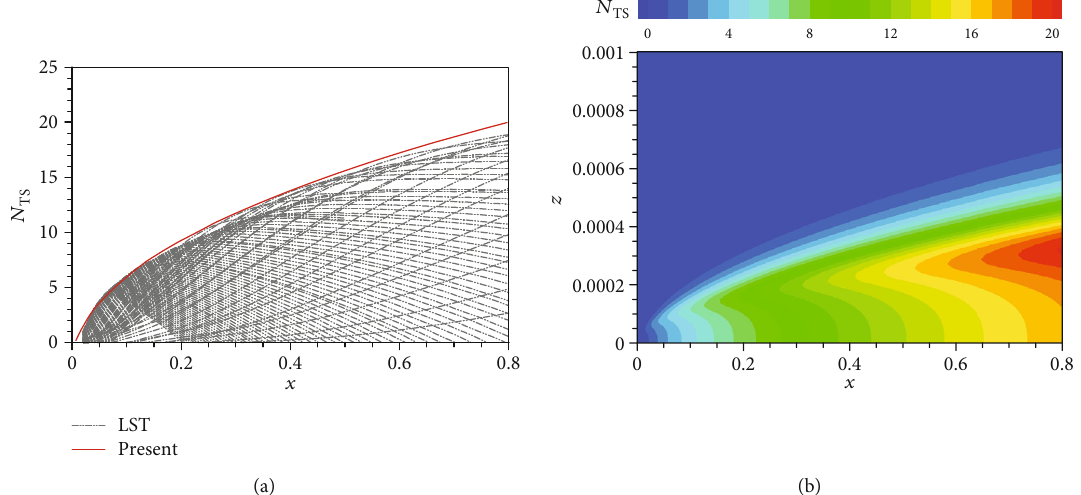
Figure 4: Predicted results of ampli fi cation factor. (a) Comparison with standard LST analysis results. (b) Contour at Mach number = 1 : 5 and Reynolds number = 5 : 4 × 10 7 /m